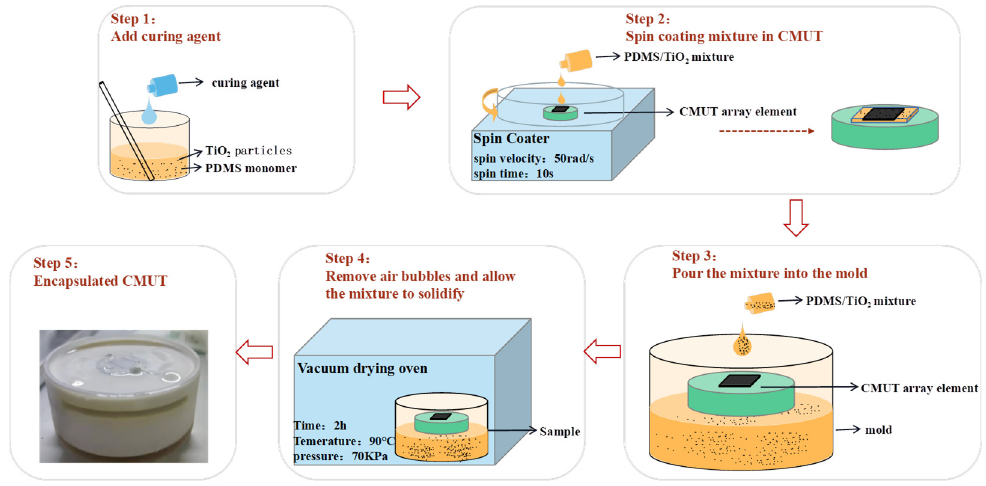
Figure 10. Preparation setup of CMUT packaging.